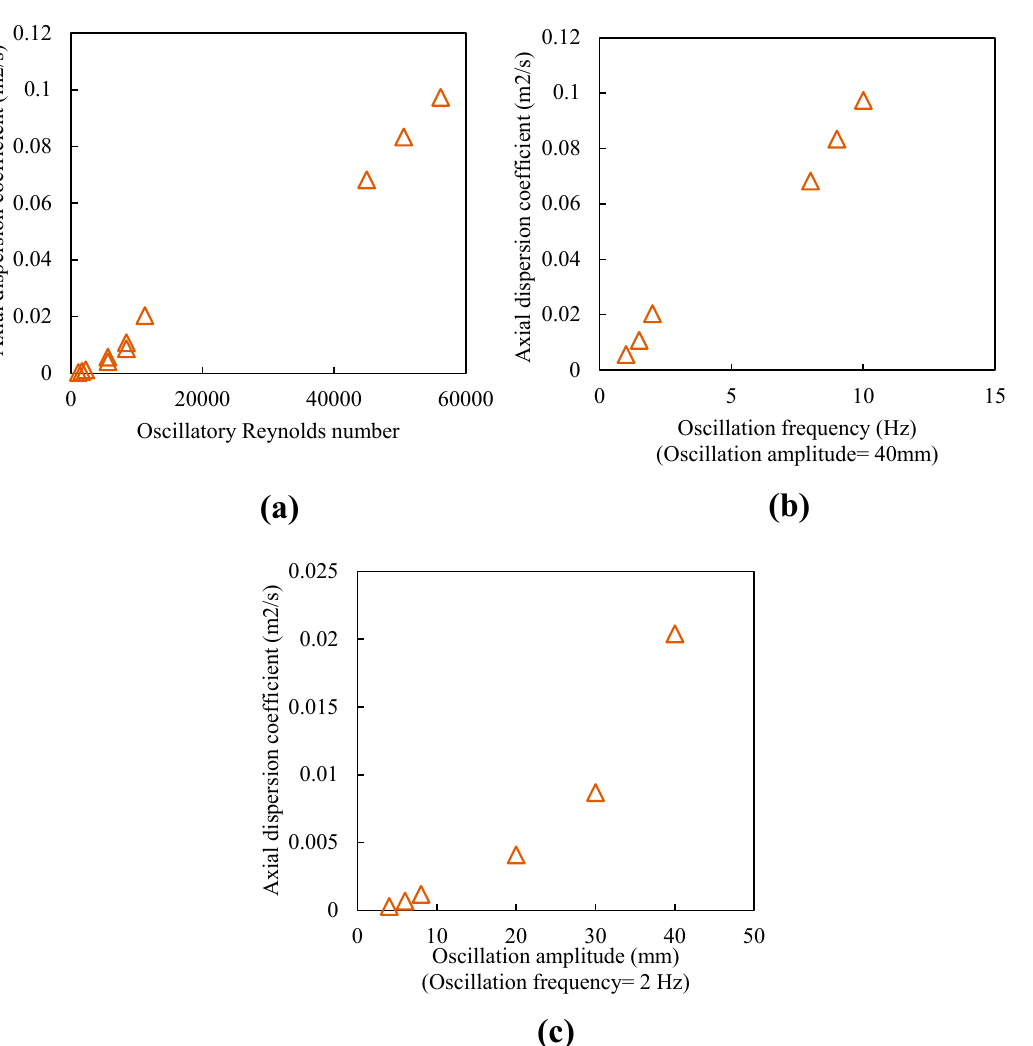
Figure 11. Axial dispersion coefficient versus (a) oscillatory Reynolds number, (b) oscillation frequency, and (c) oscillation amplitude.